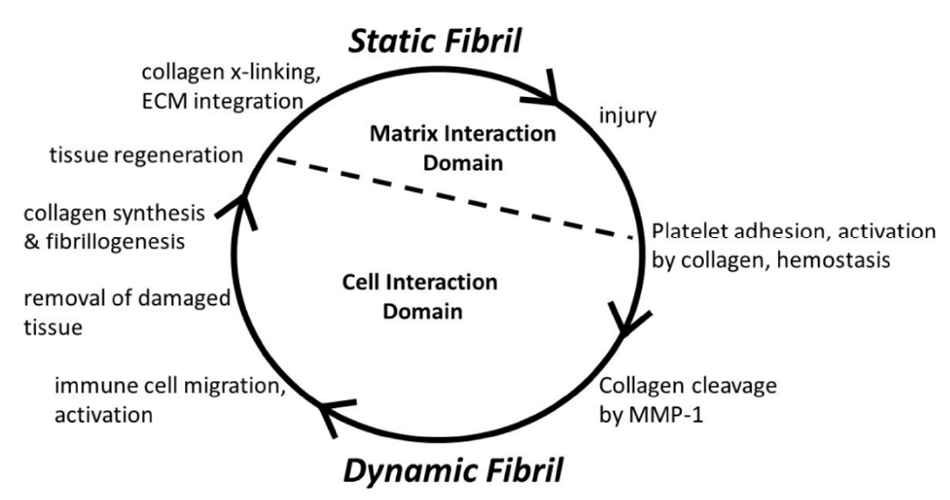
Figure 5. Schematic of conditional cell and matrix interaction domain model of type I collagen fibril function. See text and Figure 3 for details.